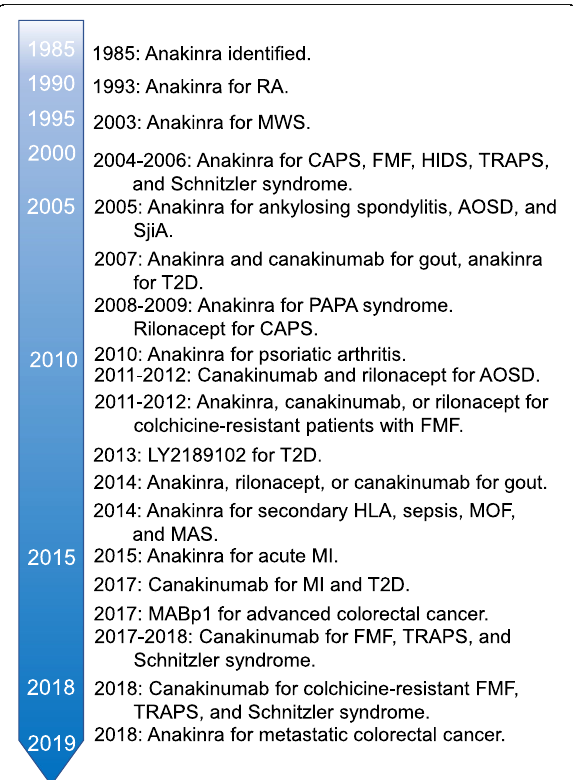
Fig. 2 Timeline of anti-IL-1 therapy as described in the text. RA, rheumatoid arthritis; MWS, Muckle – Wells syndrome; CAPS, cryopyrin- associated periodic syndrome; FMF, familial Mediterranean fever; HIDS, hyper-IgD syndrome; TRAPS, TNF-receptor-1-associated periodic syndrome, AOSD, adult-onset Still ’ s disease; SjiA, systemic juvenile; T2D, type 2 diabetes mellitus; HLH, hemophagocytic lymphohistiocytosis; MOF, multiple organ failure; MAS, macrophage-activating syndrome; MI, myocardial infarction